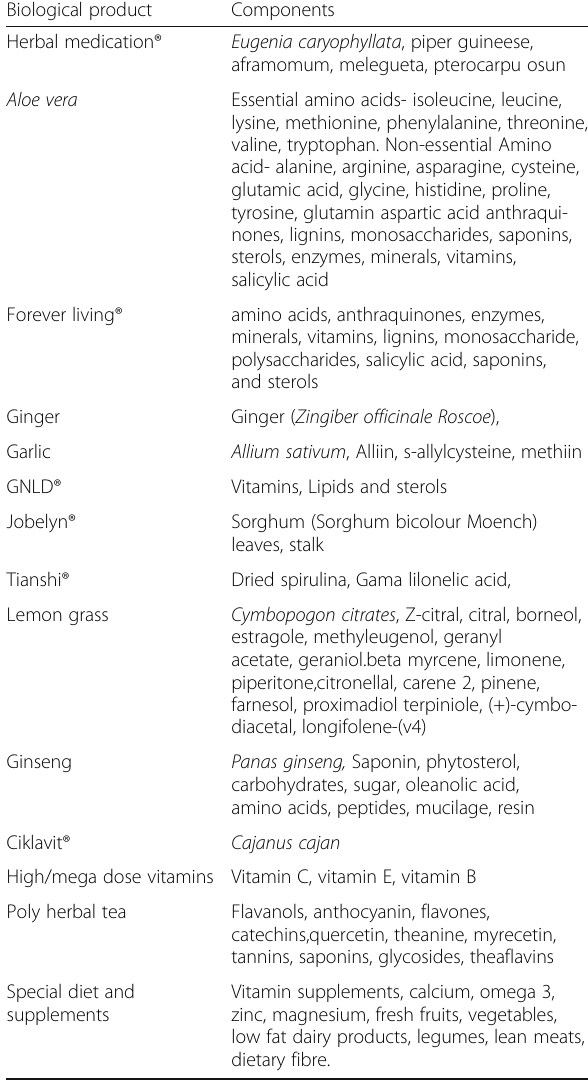
by the respondents Biological